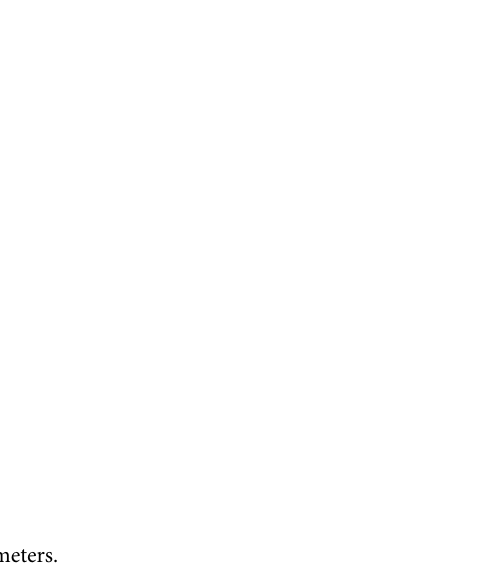
Table 3. Values of θ ′ ( 0 ) for different physical flow